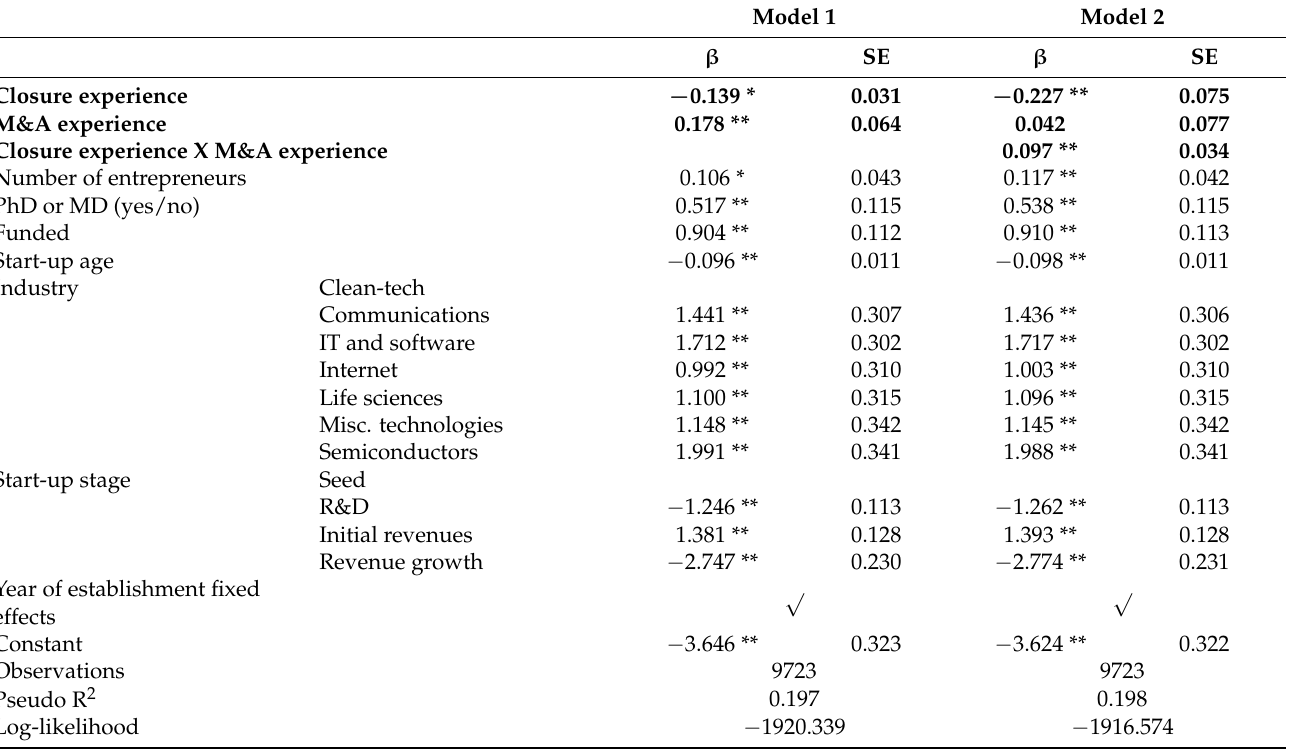
Table 2. The effect of entrepreneurs’ experience on the probability of